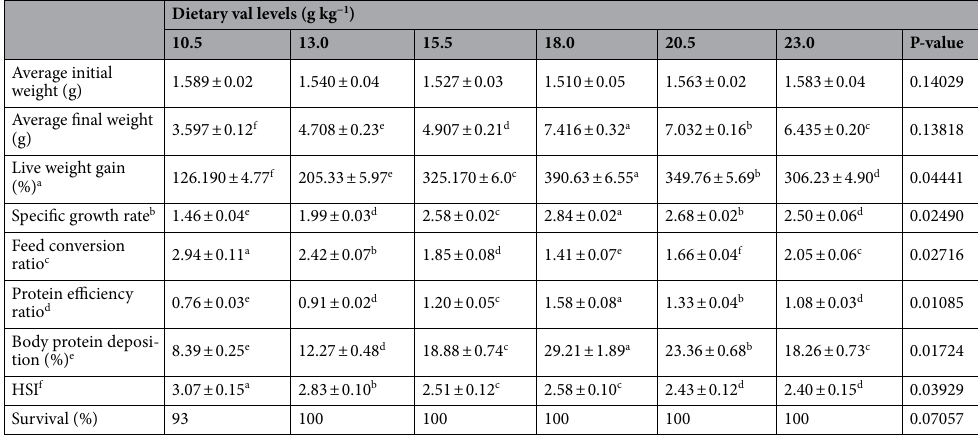
Table 1. Growth, FCR, protein deposition and percentage survival of rainbow trout, Oncorhynchus mykiss fingerlings fed diets containing varying levels of dietary valine for 8-weeks (mean values of 3 replicates + SEM; n = 3) * a Weight gain (%), Final body weight–initial body weight/initial weight × 100. b Specific growth rate (SGR %) = 100 × (In final wet weight (g)-In initial wet weight g)/duration (days). c Feed conversion ratio (FCR) = Dry weight of feed consumed / Wet weight gain. d Protein efficiency ratio (PER) = Wet weight gain (g) / Protein consumed (g, dry weight basis). e Body protein deposition (BPD %) = 100 × (BWf × BCPf) – (BWi × BCPi) / [TF × CP]. Where BWi and BWf = mean initial and final body weight (g), BCPi and BCFf = mean initial and final percentage of muscle protein, TF = Total amount of diet consumed and CP = Percentage of crude protein of the diet. f HSI, Hepatosomatic index. LWG y = – 881.92287 + 131.22757 X – 3.45508 X2 (R 2 = 0.936). FCR y = 9.84738 – 0.89376 X + 0.02409 X2 (R 2 = 0.951). PER y = –1.62689 + 0.30437 X – 0.00803 X2 (R 2 = 0.823). BPD y = –38.47152 + 6.02386 X – 0.15135 X2 (R 2 =